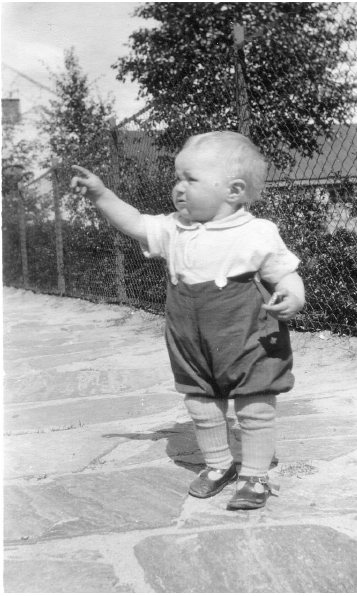
Figure 2: One-year old Jens Glad Balchen enjoying the Norwegian National Day on May 17th,